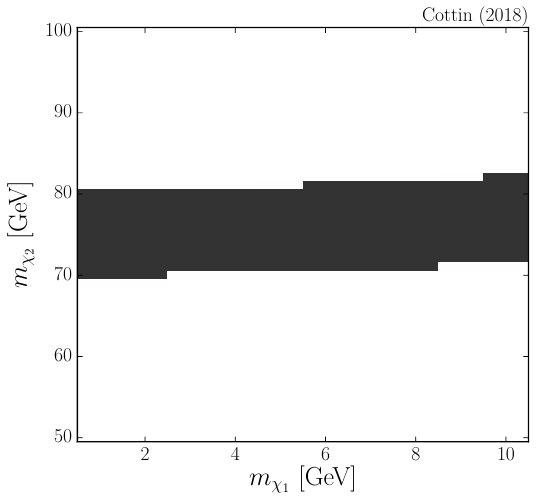
Figure 5 . Median 95% con(cid:12)dence region for (cid:12)ve observations of the mass pair ( m (cid:31) observations are in table